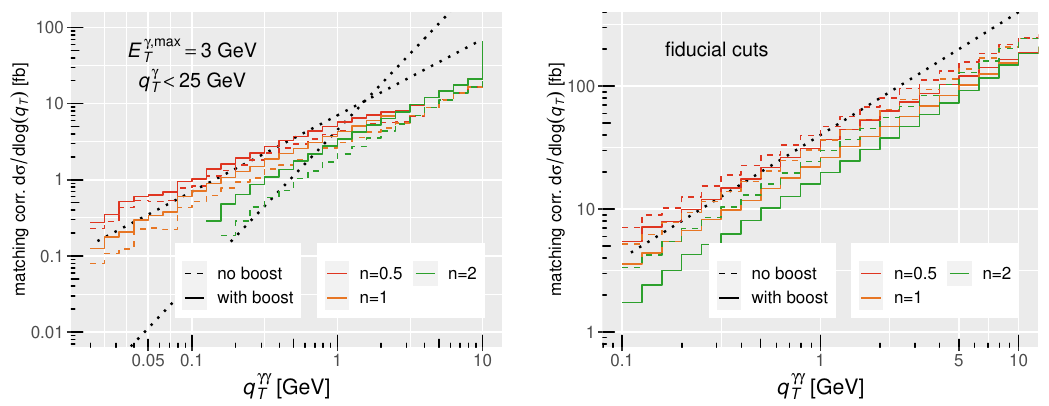
Figure 14. Matching corrections at N 2 LL for diphoton production with photon q T and photon isolation cuts only (left) and all fiducial cuts in table 4 (right). The different colors correspond to different values of n . The solid lines are the power corrections after accounting for recoil, the dashed lines are without recoil. The black dotted lines indicate first and second order scaling in q T to guide the